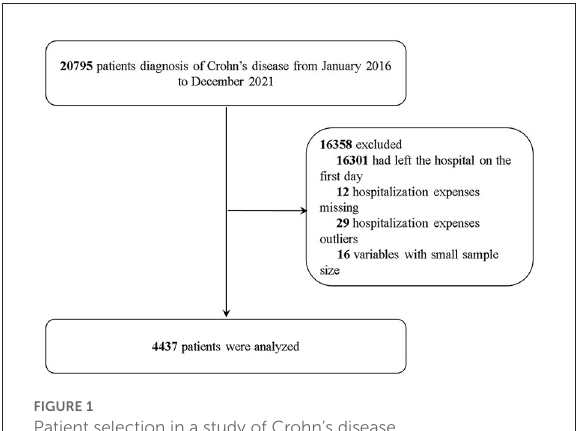
FIGURE1 Patient selection in a study of Crohn’s disease.